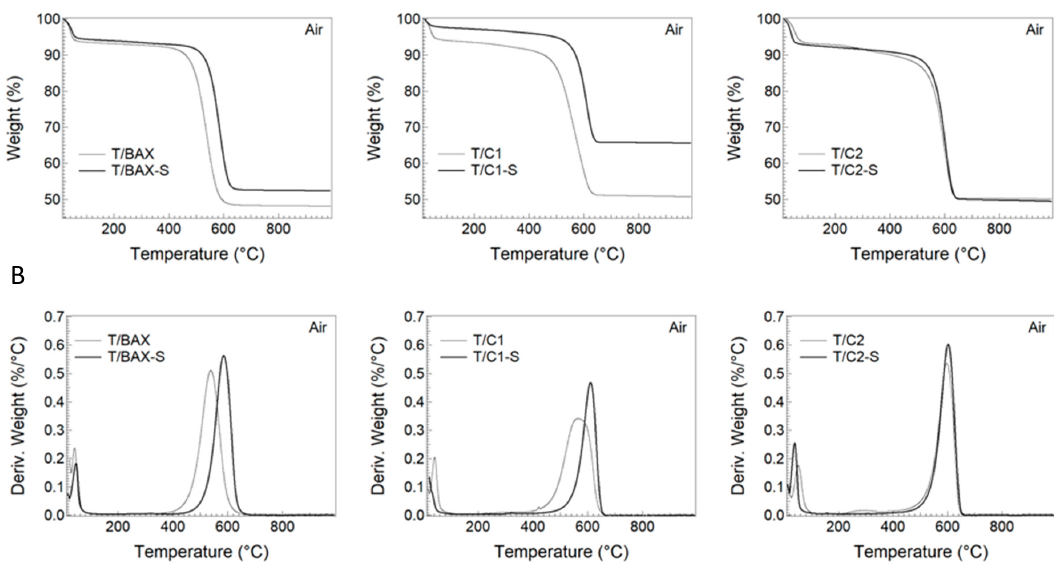
Figure 1. ( A ) TG and ( B ) DTG curves in air for the hybrids studied.